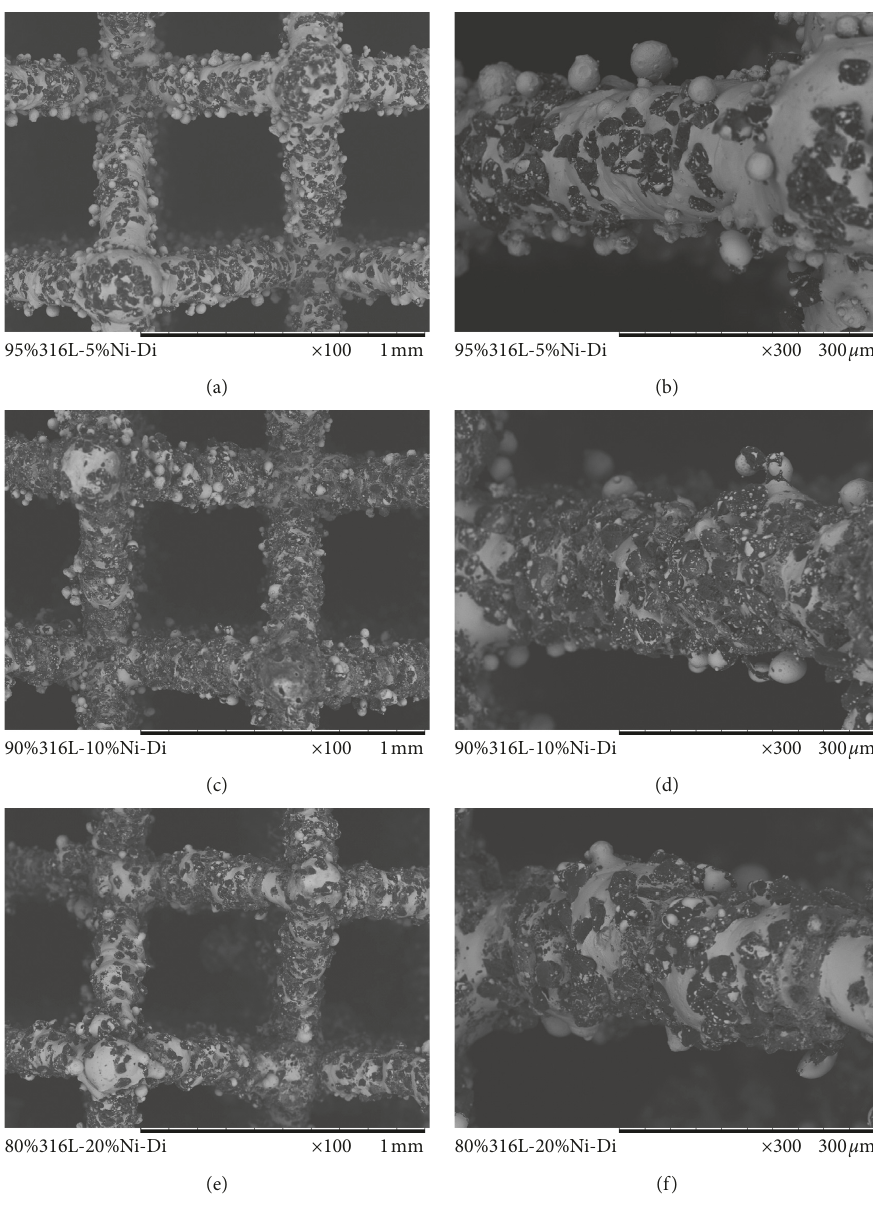
Figure 6: SEM images of 316L-diamond (nickel-coated) lattice.